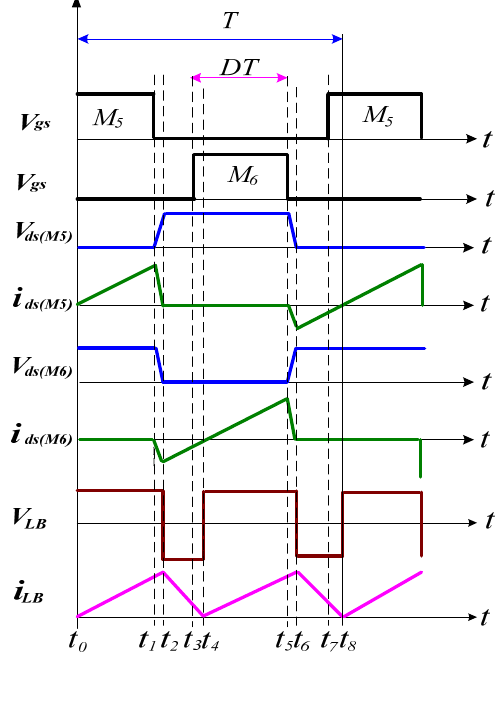
Figure 8. Driving signals of switches ( M waveforms of key components for voltage equalization